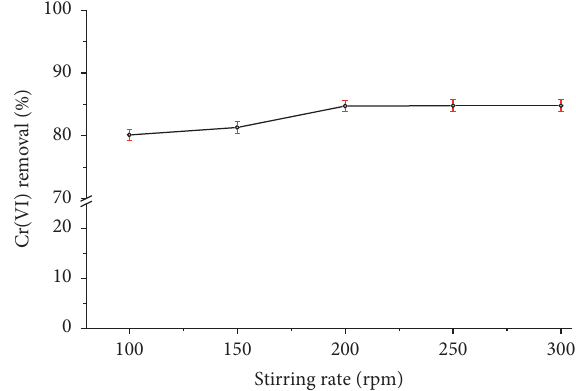
Figure 4: Effect of stirring speed on removal of Cr(VI) using organobentonite. Conditions: C i � 50mg/L, V � 50 mL, T � 20 °